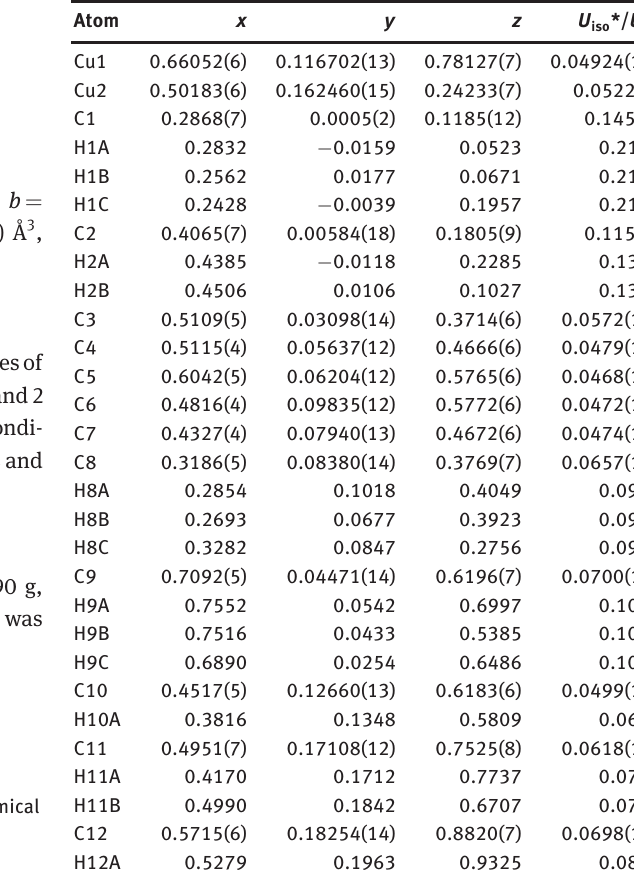
Table 2: Fractional atomic coordinates and isotropic or